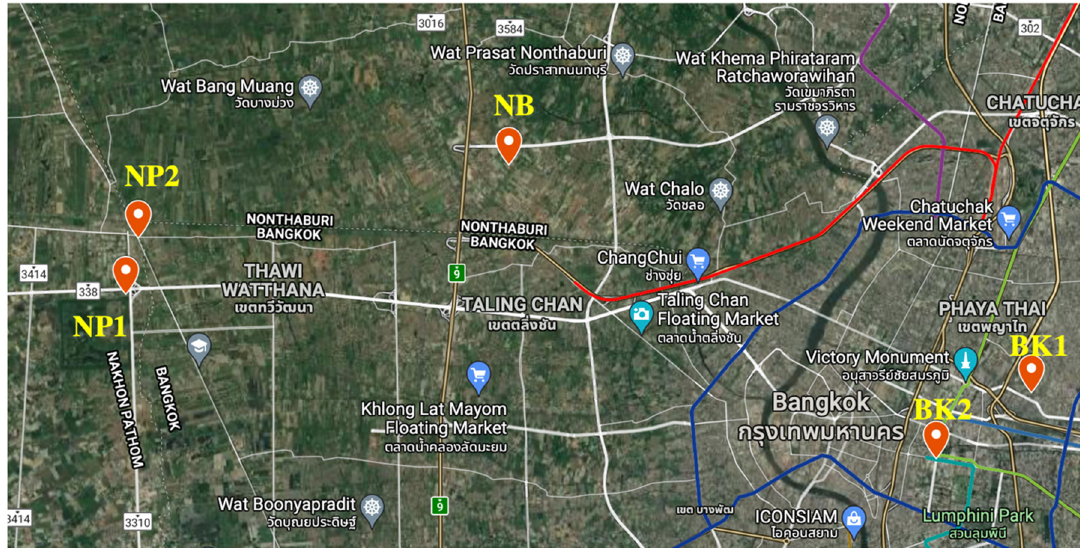
Figure 1. Locations of the air sampling sites in Bangkok (BK), and its vicinity area included Nontha- buri (NB) and Nakhon Pathom (NP).